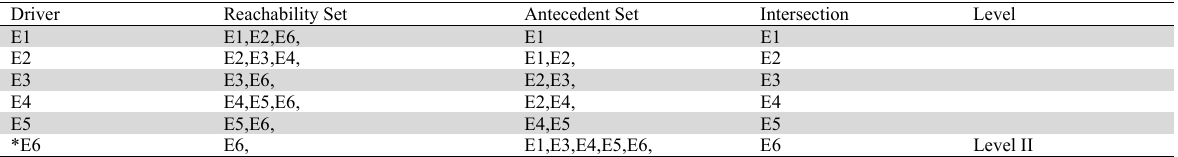
Level Partition-iteration 2